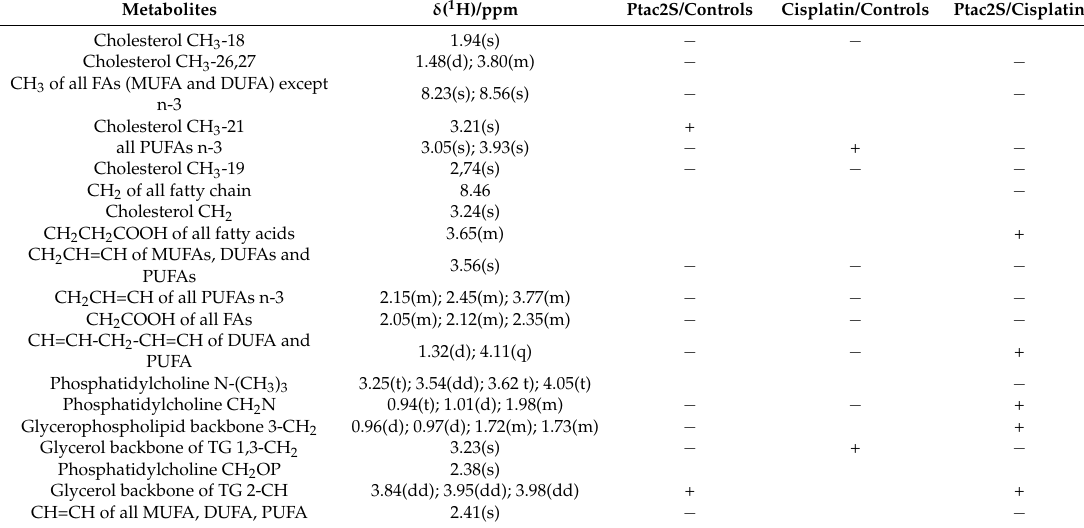
Table 2. Relevant metabolites derived from the pairwise OPLS-DA models of 1 H-NMR analysis of lipidic extracts between controls and Ptac2S and cisplatin treated samples at 24 h of treatment. Positive (+) and negative ( − ) signs indicate positive and negative correlation in the concentration,